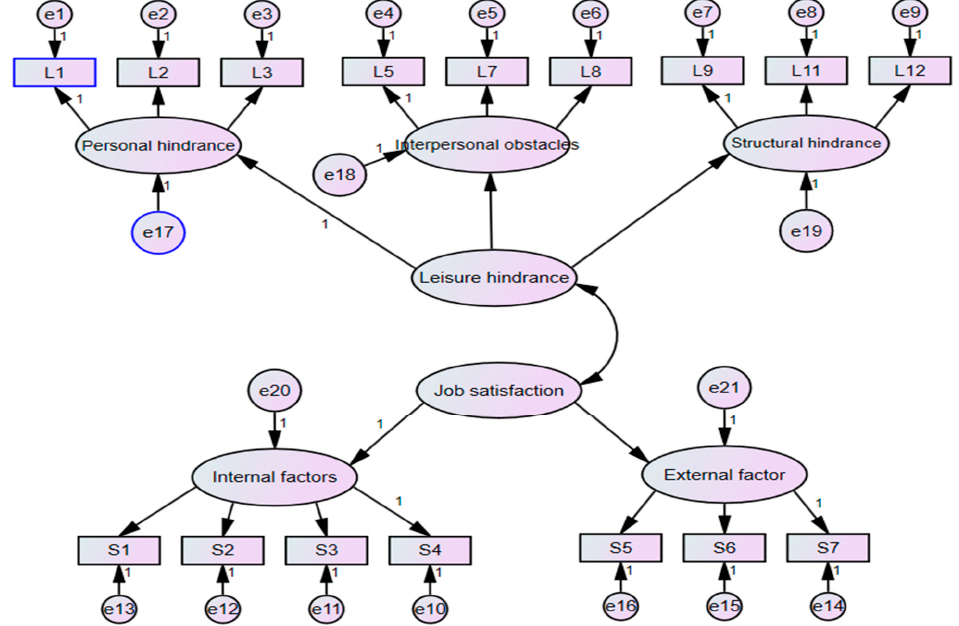
Figure 2. Structure diagram of confirmatory factor analysis of leisure obstacles and job satisfaction.